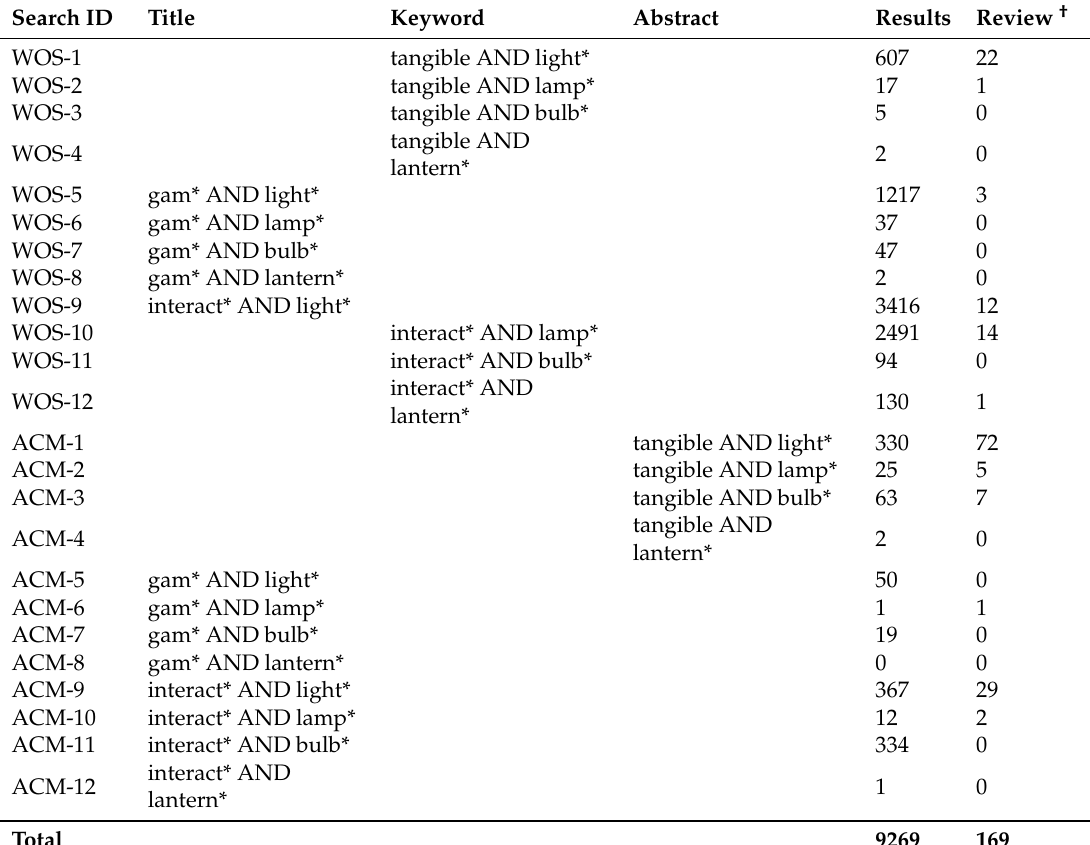
Table 2. Search procedure and reviewed results (from year 2000 to